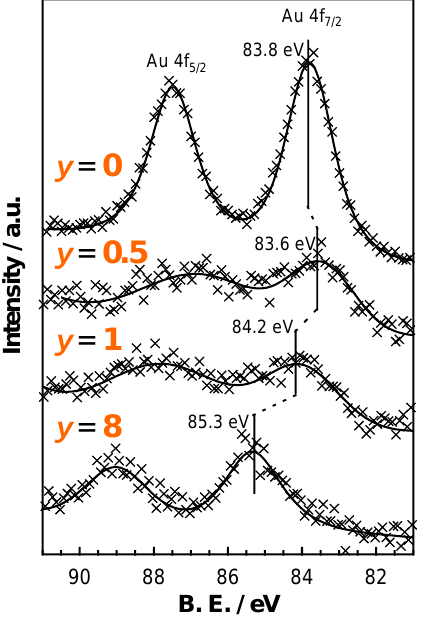
as shown in Table 2. The color of these catalysts was the same. Therefore, the loadings of